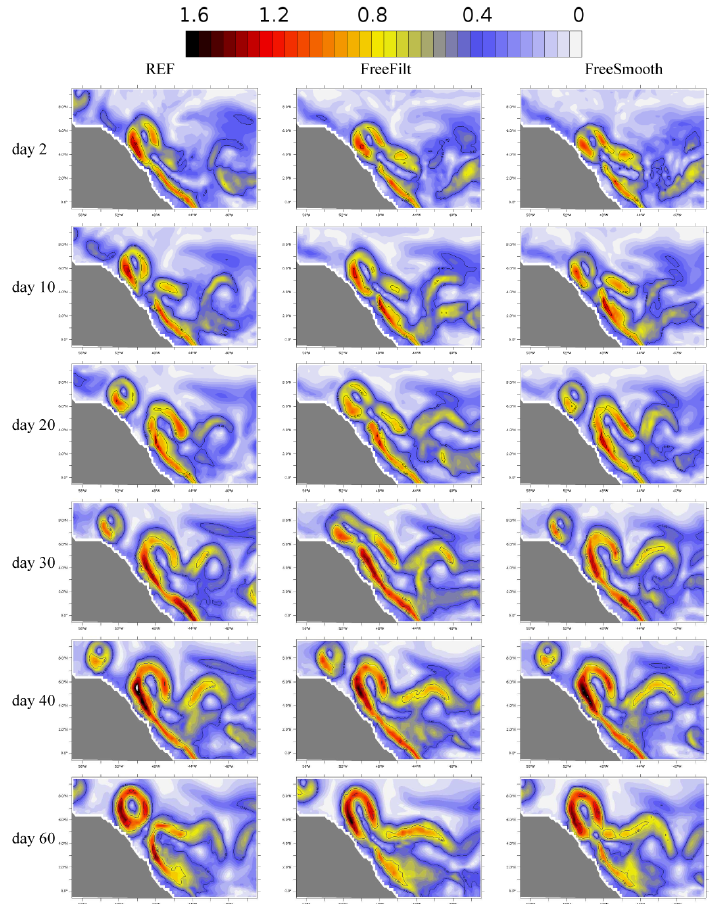
Fig. 8. Absolute error maps for the velocity (in ms − 1 ), for REF (left), FreeFilt (middle) and FreeSmooth (right). Day 0 (top) is the day of the restart. The snapshots are given every 10 days.